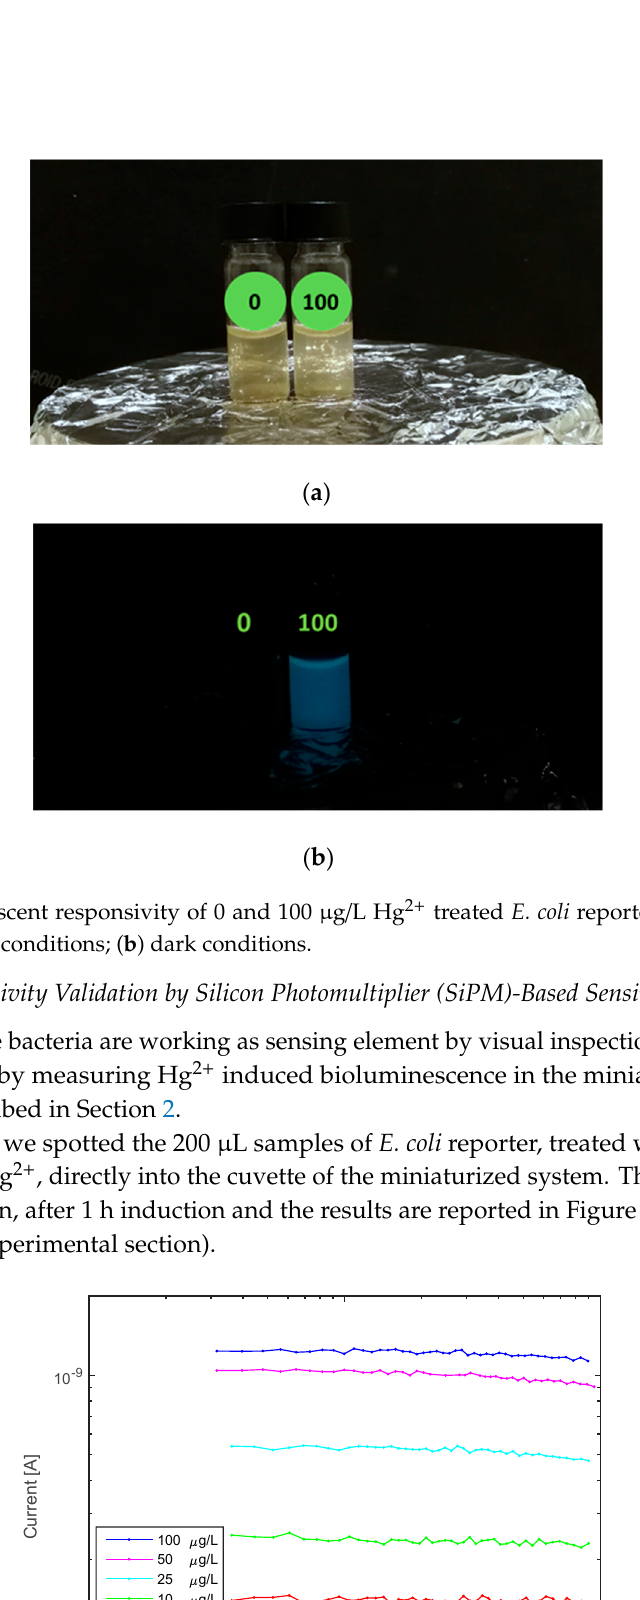
10 0 Figure 5 . Mercury-induced bioluminescence detected by the SiPM sensor: E. coli reporter samples treated with 0 (reference, black line); 0.25 (yellow line); 1 (green line); 2.5 (purple line); 10 (blue line); 25 (red line); 50 (brown line) and 100 (light blue line) µg/L Hg 2+ , for 1 h; signal measurement time: 1 min. Figure 5 shows that the miniaturized sensing system is able to detect the presence of Hg 2+ traces in water. SiPM optical detection revealed that during the first 100 s the current signal, transduced by Time [s]